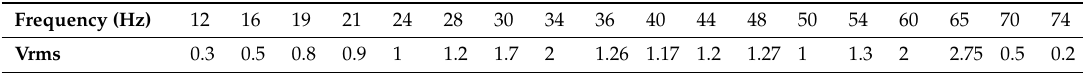
Table 3. Analytical data from the PVT.